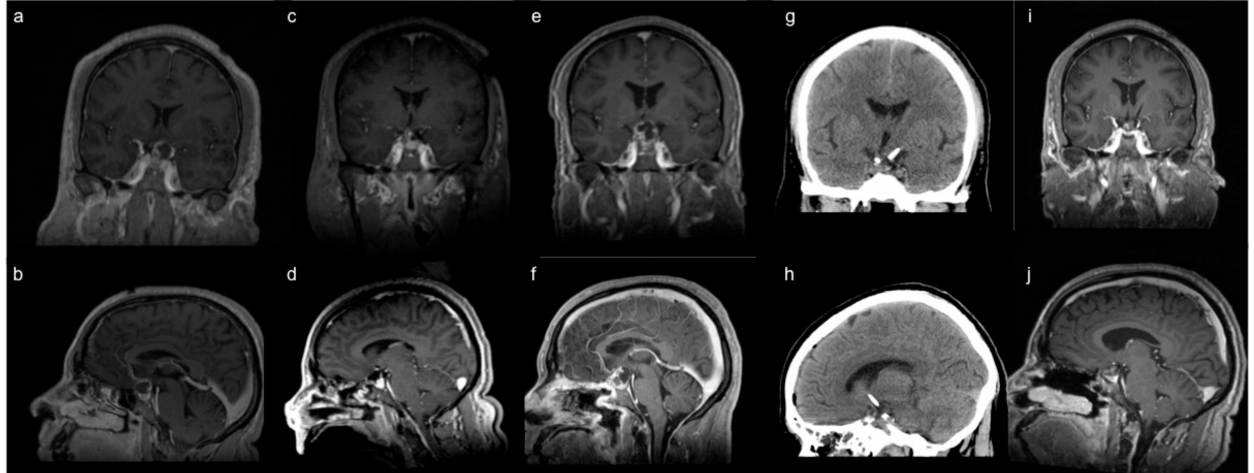
Figure 4. Ommaya reservoir placement for cystic recurrence. A 52-year-old male was diagnosed with a cystic suprasellar lesion on work-up for progressive left sided visual deficits, consistent with craniopharyngioma. Representative ( a ) coronal and ( b ) sagittal T1-weighted post-contrast MRI showed a predominantly cystic, enhancing 1.5 cm suprasellar lesion compressing the optic nerves, eccentric to the left. Intra-operative ( c ) coronal and ( d ) sagittal T1-weighted post-contrast MRI after resection demonstrated decompression of the optic chiasm and nerves with known adherent residual tumor left intentionally along the cavernous sinus. ( e ) Coronal and ( f ) sagittal T1-weighted post-contrast MRI obtained 5 months after initial resection showed cystic recurrence in the setting of recurrent visual decline. This was treated with Ommaya reservoir placement, as depicted on ( g ) coronal and ( h ) sagittal post-operative head CT, followed by adjuvant stereotactic radiosurgery. ( i ) Coronal and ( j ) sagittal T1-weighted post-contrast MRI obtained 3 months after cyst drainage